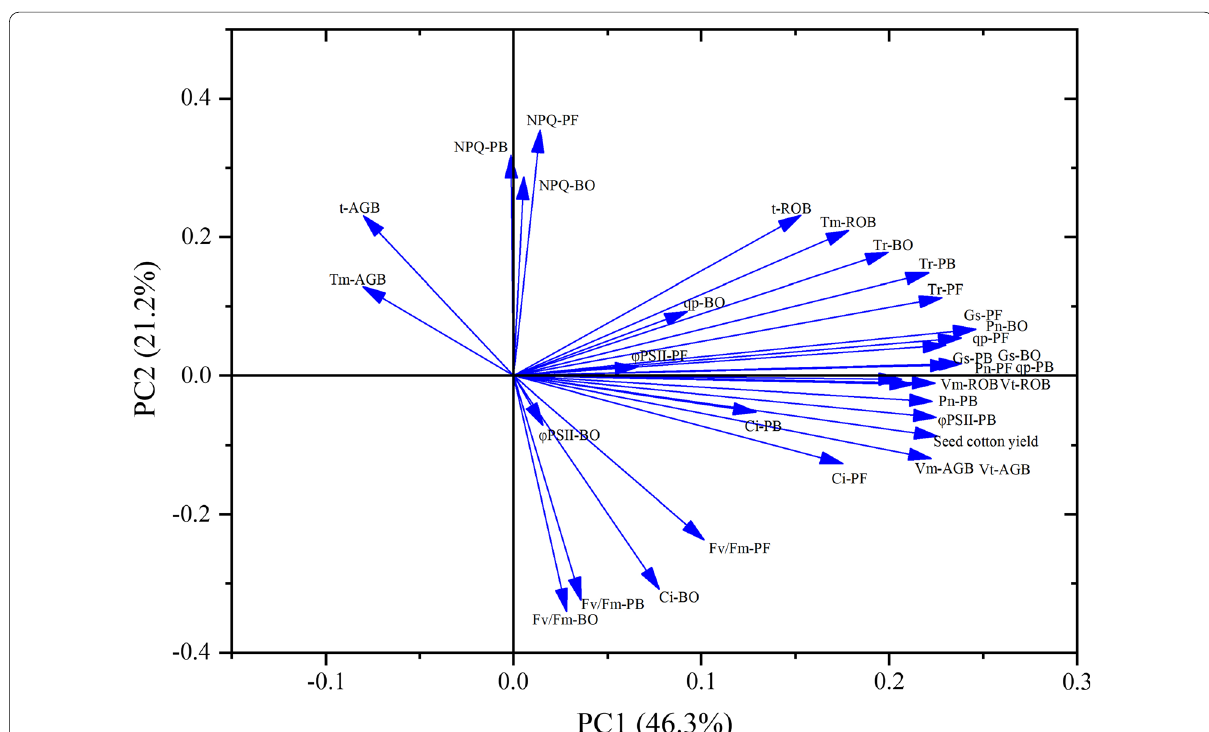
Fig. 3 Principal component analysis of various indices at different growth stages. PF, peak flowering stage; PB, peak boll stage; BO, boll opening stage; AGB, aboveground biomass; ROB, reproductive organ biomass; F v/ F m, φ PSII, q P, and NPQ represent the primary light energy conversion efficiency of PSII in the dark, quantum yield of PSII, coefficient of photochemical quenching and coefficient of nonphotochemical quenching, respectively. P n, G s, C i, and T r represent the net photosynthetic rate, stomatal conductance, intercellular CO 2 concentration and transpiration rate, respectively. t, Tm, and Vm represent the duration of the fast growth period, occurrence time of maximum speed during the fast growth period and maximum speed of biomass accumulation during the fast growth period,